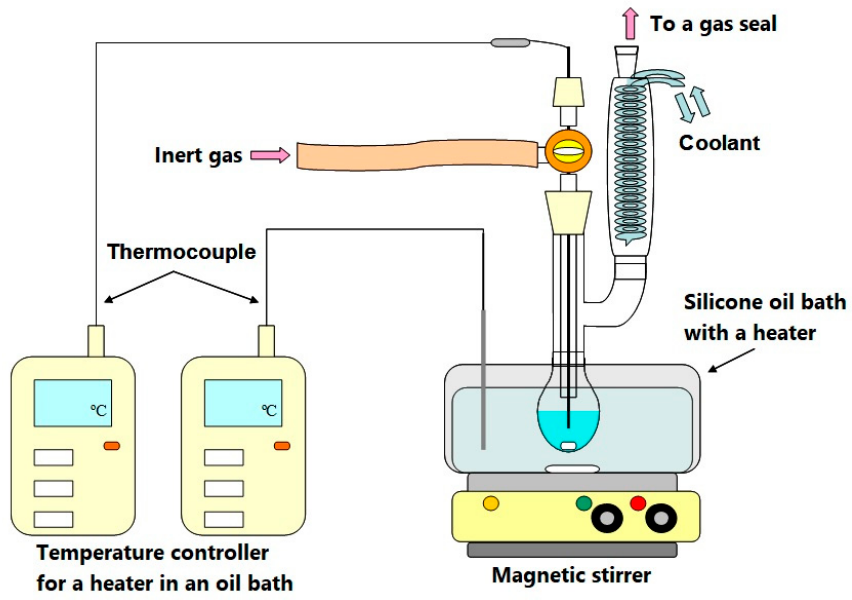
Figure 2. Schematic diagram of a decomposition equipment.